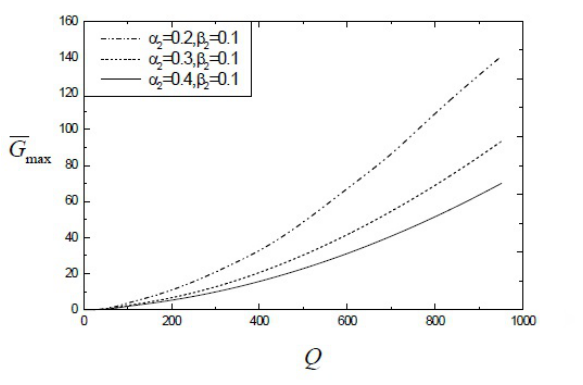
Fig. 10. Effect of boundary condition on maximum of energy release rate.